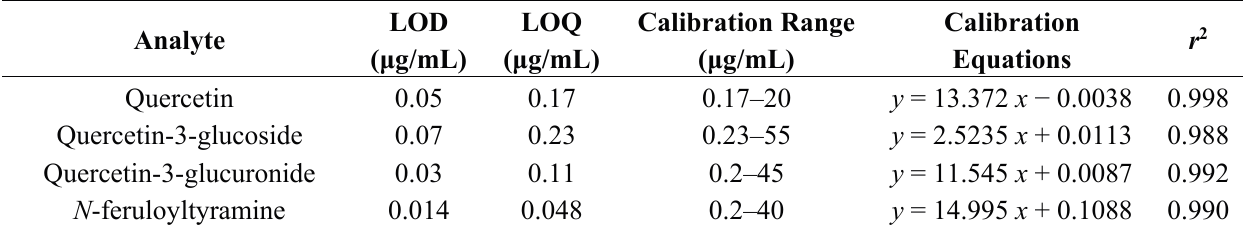
Table 3. Calibration data, where LOD is the limit of detection and LOQ is the limit of quantification.